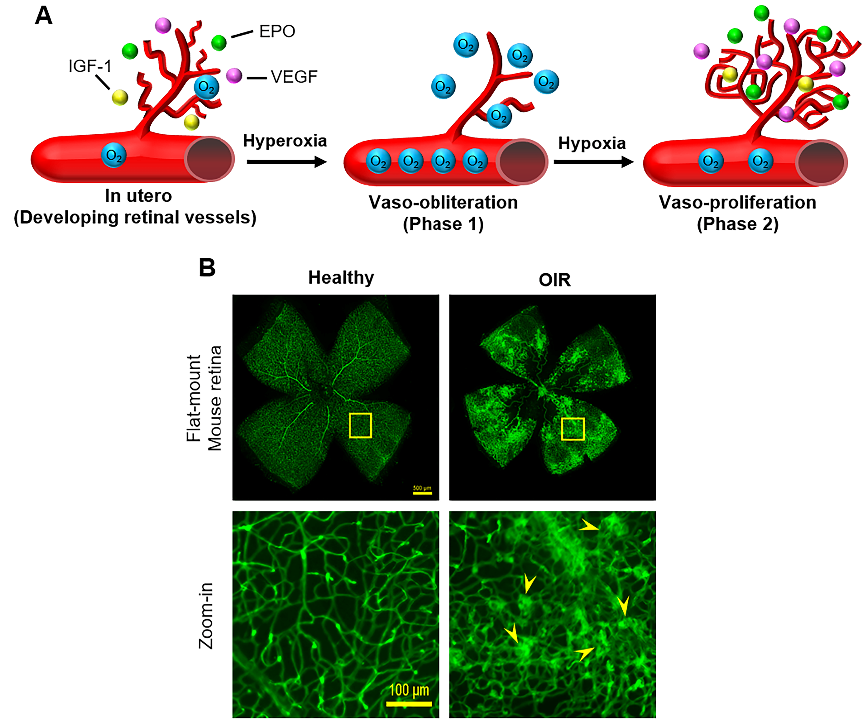
Figure 3. ( A ) Two phases of human ROP and ( B ) Healthy and OIR flat-mount mouse retina stained with Alexa Fluor 488-conjugated isolectin B4. Scale bar = 500 (top row) and 100 µ m (bottom row). Arrowheads indicate pathological retinal neovascularization and neovascular tufts.